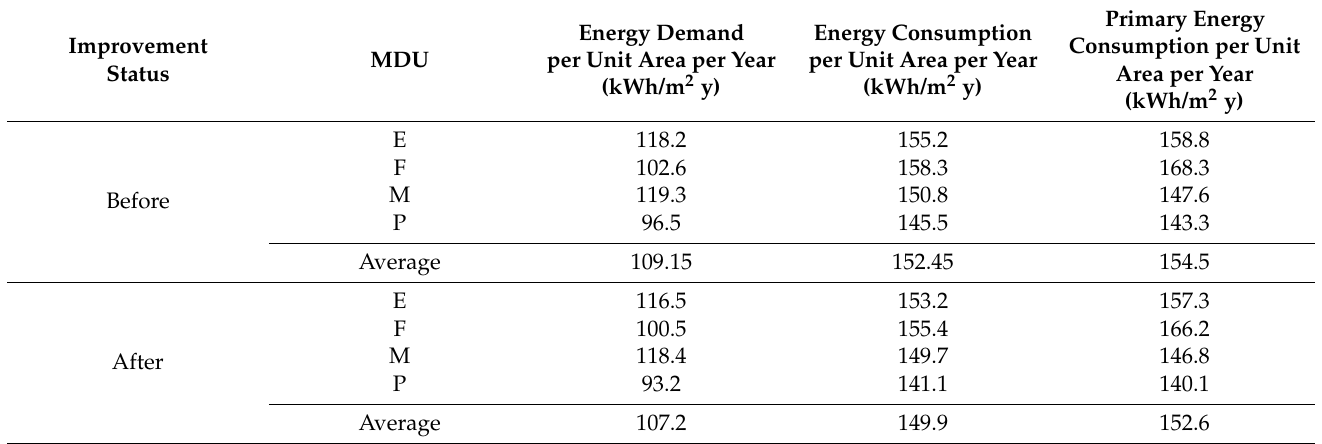
Table 4. Changes in energy demand and energy consumption of E, F, J, M, and P MDU complexes before and after exterior wall improvement.